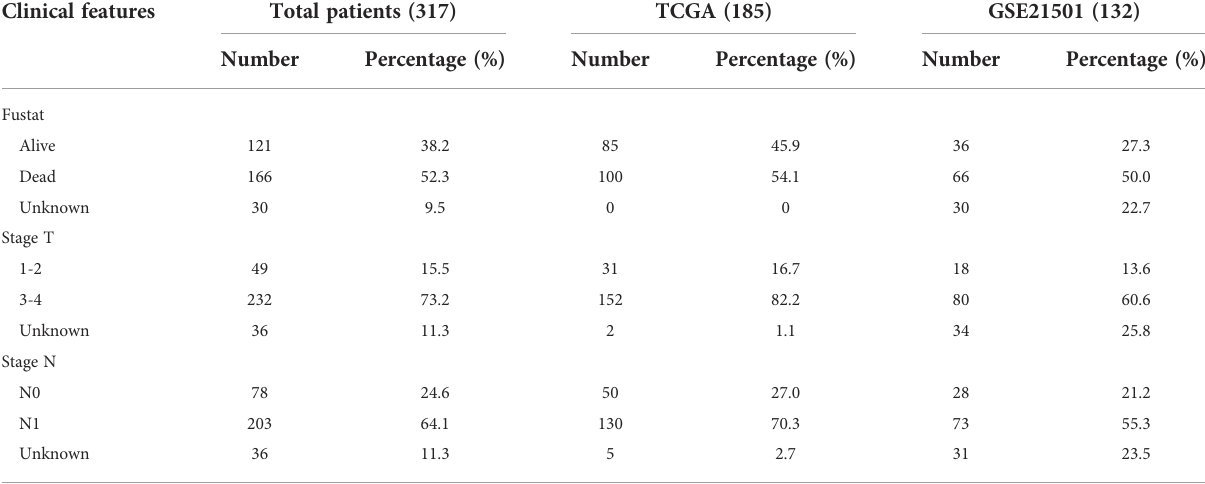
TABLE 2 Baseline characteristics of patients from TCGA and GEO